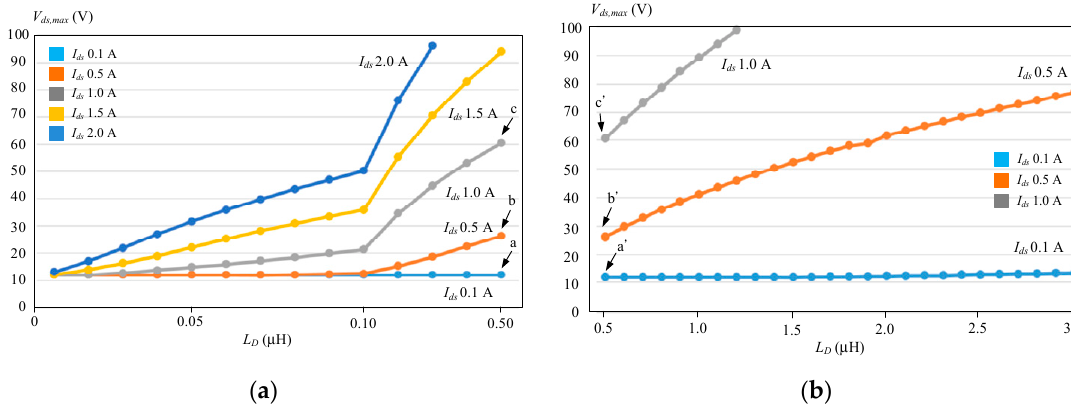
Figure 4. Changes in V ds when different I ds values are applied. ( a ) Changes in V ds,max for various I ds values ( L D ranges from 0.01–0.50 μ H). ( b ) Changes in V ds,max for various I ds values ( L D ranges from 0.5–3.0 μ H).